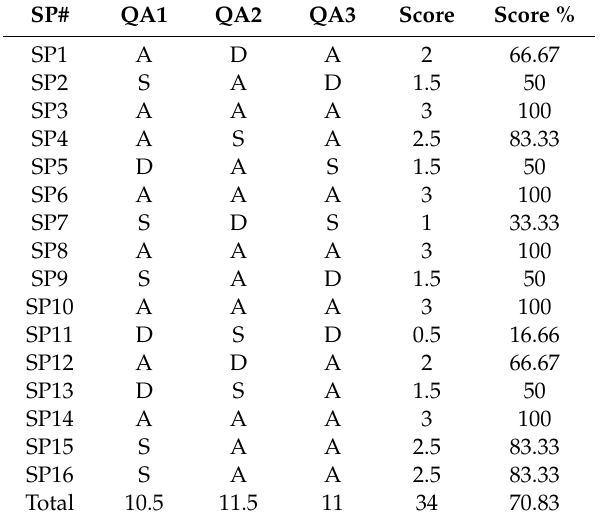
Table 6. Quality assessment of selected research papers on deep learning.